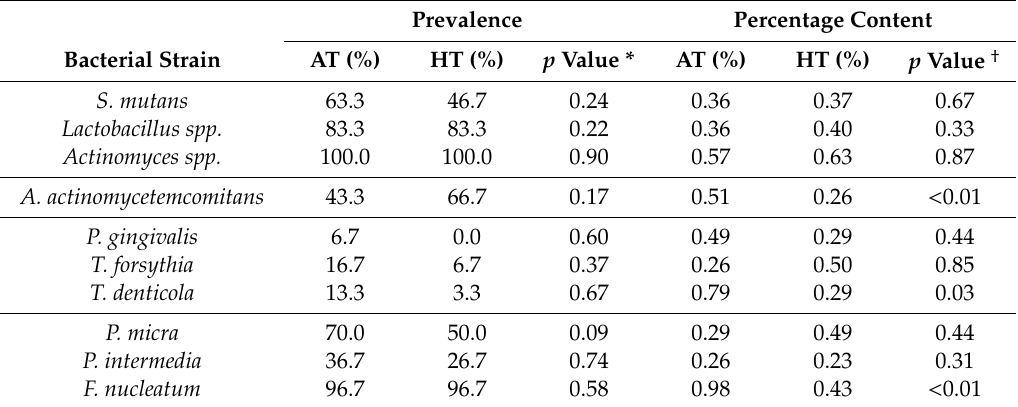
Table 3. The prevalence and percentage content of bacteria detected in the sample from the area of healthy teeth (HT) and a ff ected teeth (AT).